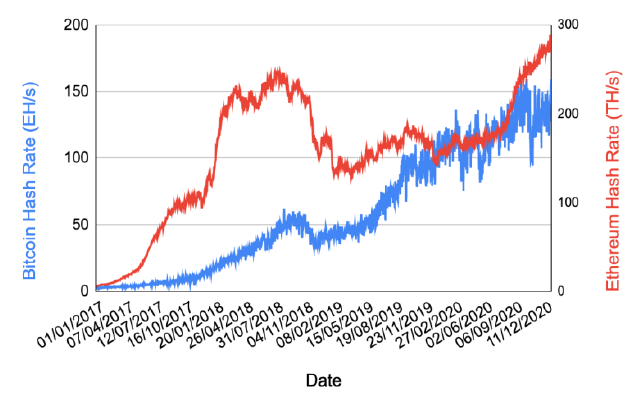
Figure 16: Bitcoin and Ethereum hash rates.